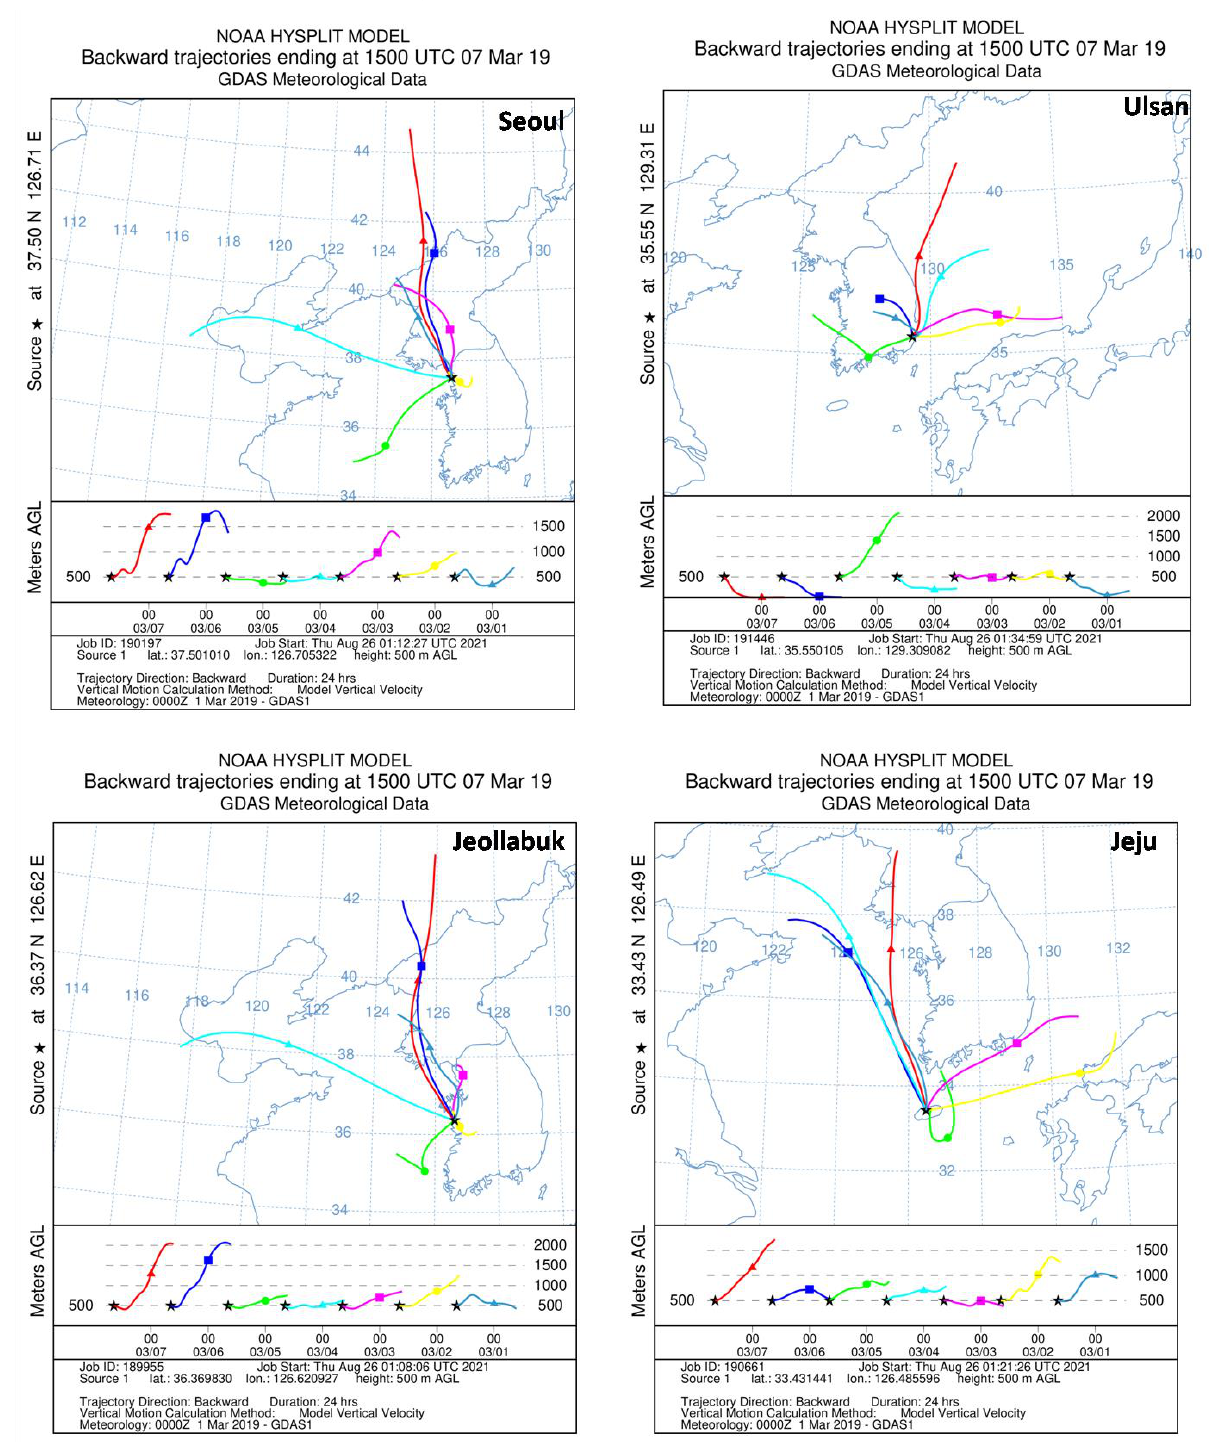
Figure 4. Backward trajectories of air masses derived from the Hysplit model for 1–5 March 2019 arriving at four sites in South Korea.